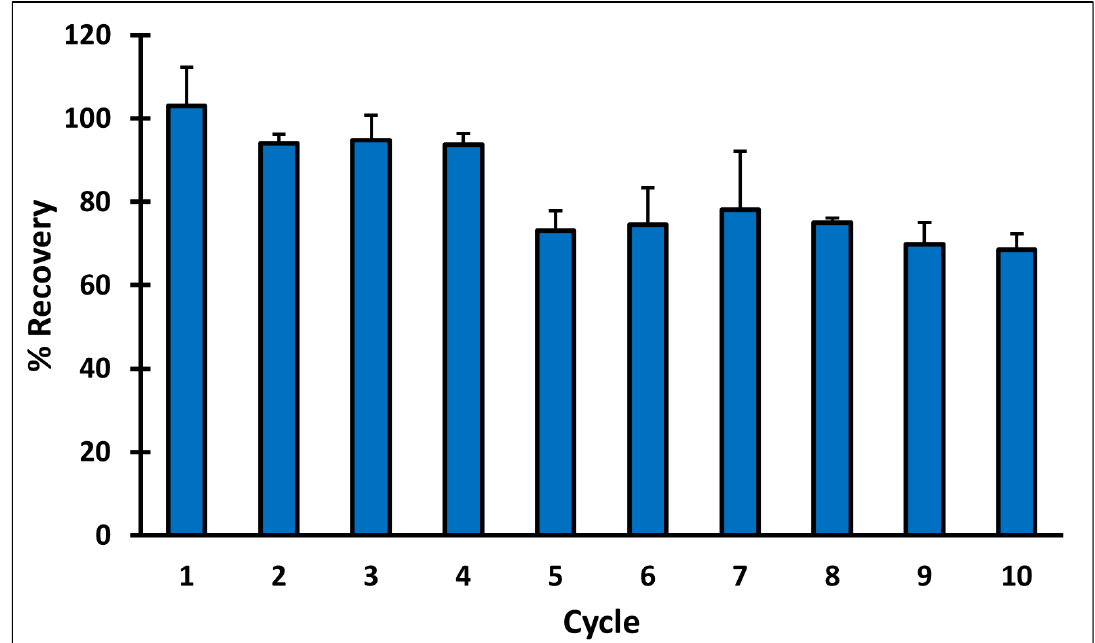
Figure 7. Percent recovery of QA during different cycles of reusing MIP C.